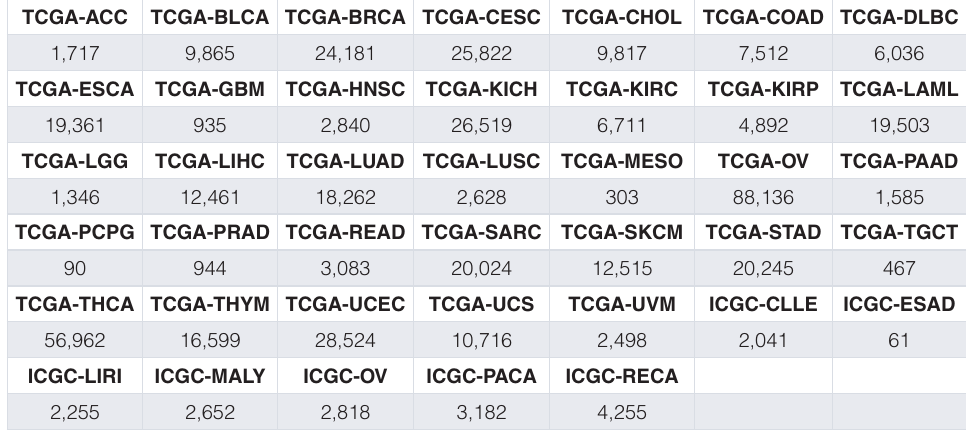
Table 1. Unique Flagged Variants by TCGA and ICGC Tumor Tissue